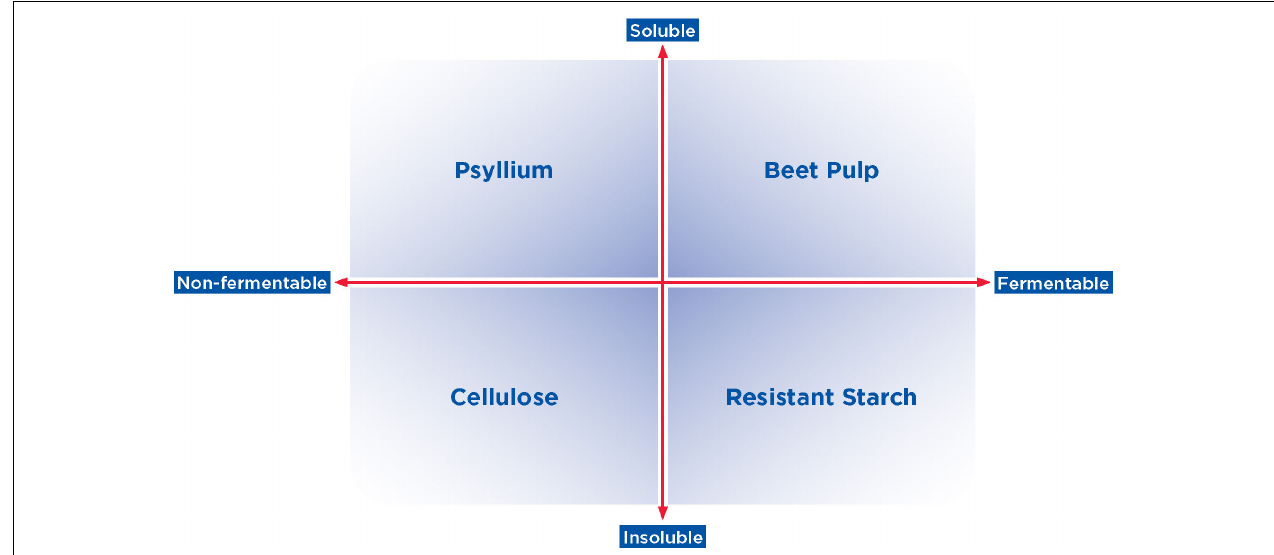
FIGURE 2 | Spectrum of solubility and fermentability of complex carbohydrates and fiber. Common fiber sources used in the pet food industry, such as those shown here, vary in their degree of solubility and fermentability (upper quadrants: more soluble; lower quadrants: less soluble; left quadrants: less fermentable; right quadrants: more fermentable). Examples of fibers that generally represent each combination of solubility and fermentability are